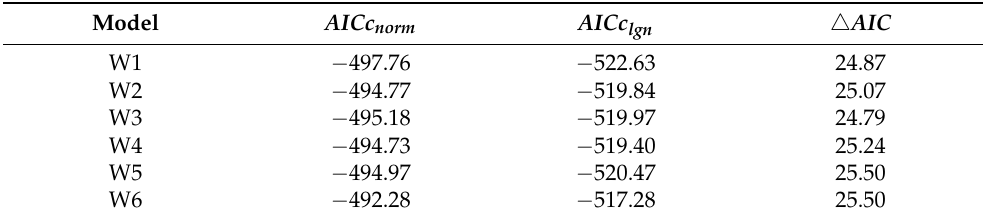
Table 2. Statistics of likelihood analysis for the error structure of shoot sheath biomass models of Moso bamboo.